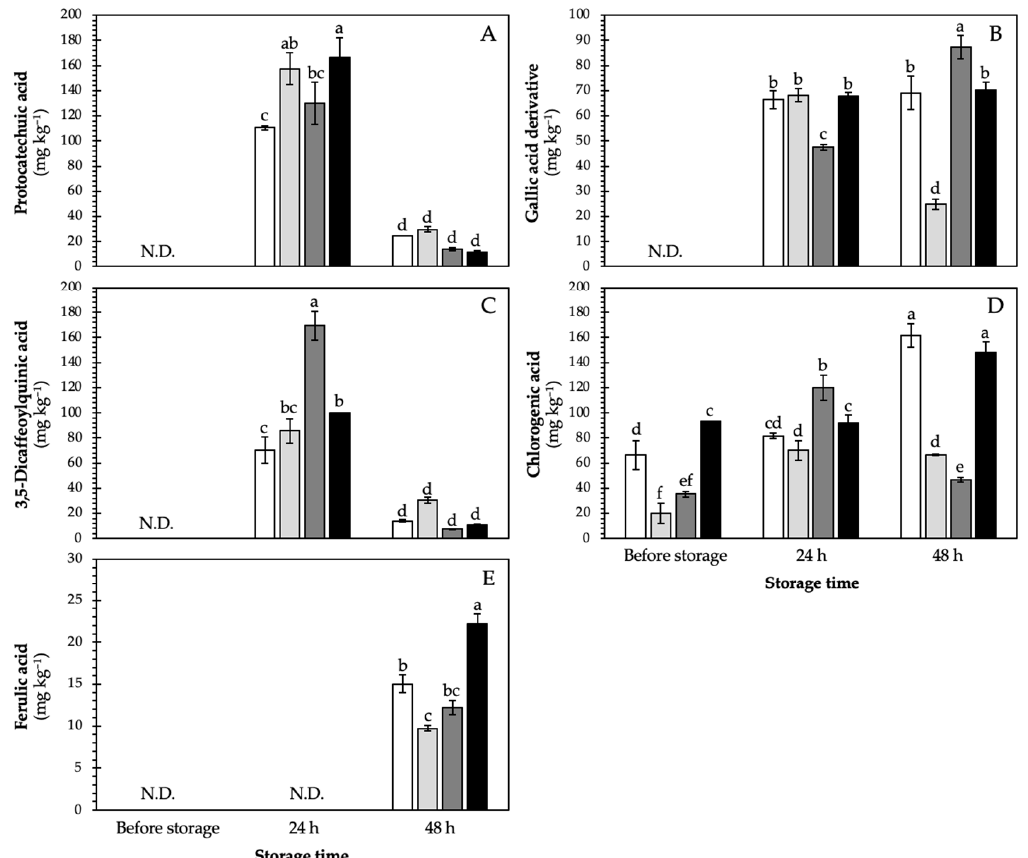
Figure 3. Concentration of individual phenolic compounds in carrot pomace treated with UVC for 0 (control), 30, 60, or 120 min, and stored at 25 ◦ C for 48 h. Data represent the mean of 3 repetitions ± the standard error of the mean. Different letters among bars (a, b, c, d, e, and f) indicate a statistical difference between treatments using the LSD test ( p < 0.05). Individual phenolic compounds identified and quantified were: protocatechuic acid ( A ); gallic acid derivative ( B ); 3,5-dicaffeoylquinic acid ( C ); chlorogenic acid ( D ); ferulic acid ( E ). N.D. = not detected. At 48 h of storage, the concentration of protocatechuic acid and 3,5-dicaffeoylquinic acid decreased to low levels (Figure 3A,C). For the gallic acid derivative, the highest ac- cumulation (26.5% higher than the control) was detected in the 60 min UVC treatment. Regarding CHA, the content remained constant in the 30 min UVC treated samples but decreased by 60.9% from 24 h to 48 h storage time. Interestingly, the control and 120 min UVC treated samples showed the largest CHA content increase, which was 143.6% and 129.9% higher than the CBS, respectively. In addition to the phenolic compounds men- tioned, ferulic acid was also detected at 48 h of storage of the carrot pomace (Figure 3E). The highest accumulation of ferulic acid was observed in the tissue treated with UVC for 120 min, whose content was 46.6% higher than the control. The ferulic acid accumulation also supports that the wound-induced activation of lignin was activated in carrot pomace since it is an essential precursor for its biosynthesis [32]. As described for total phenolics,